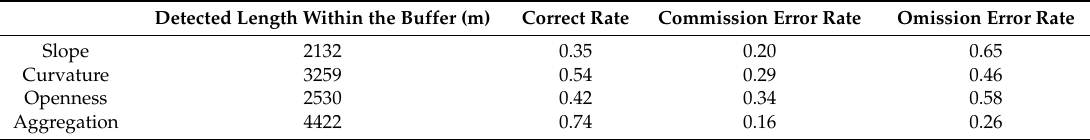
Table 1. Detected length, correct rate, commission error rate, and omission error rate.